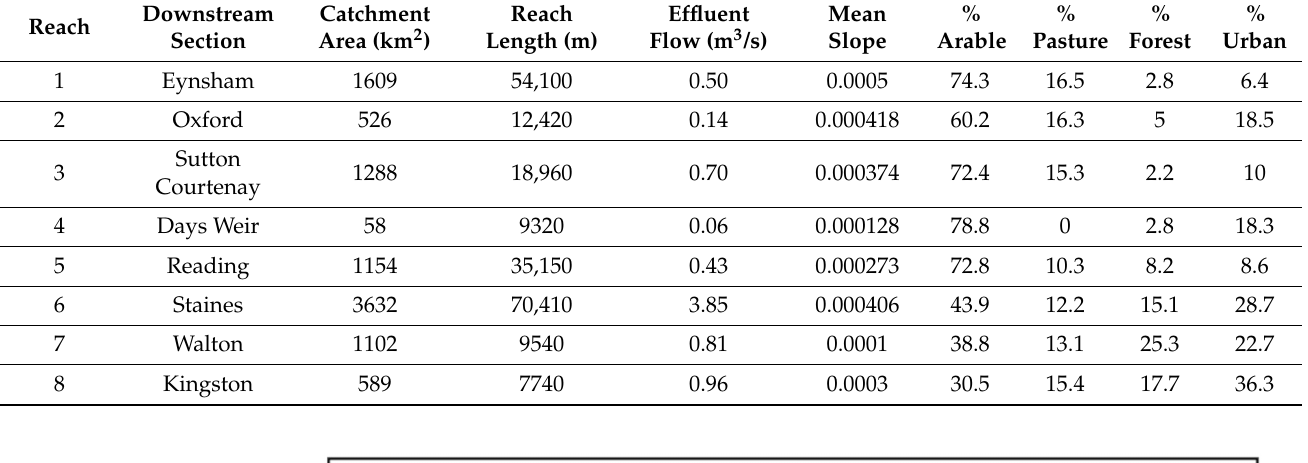
Table 1. INCA model reaches characteristics.